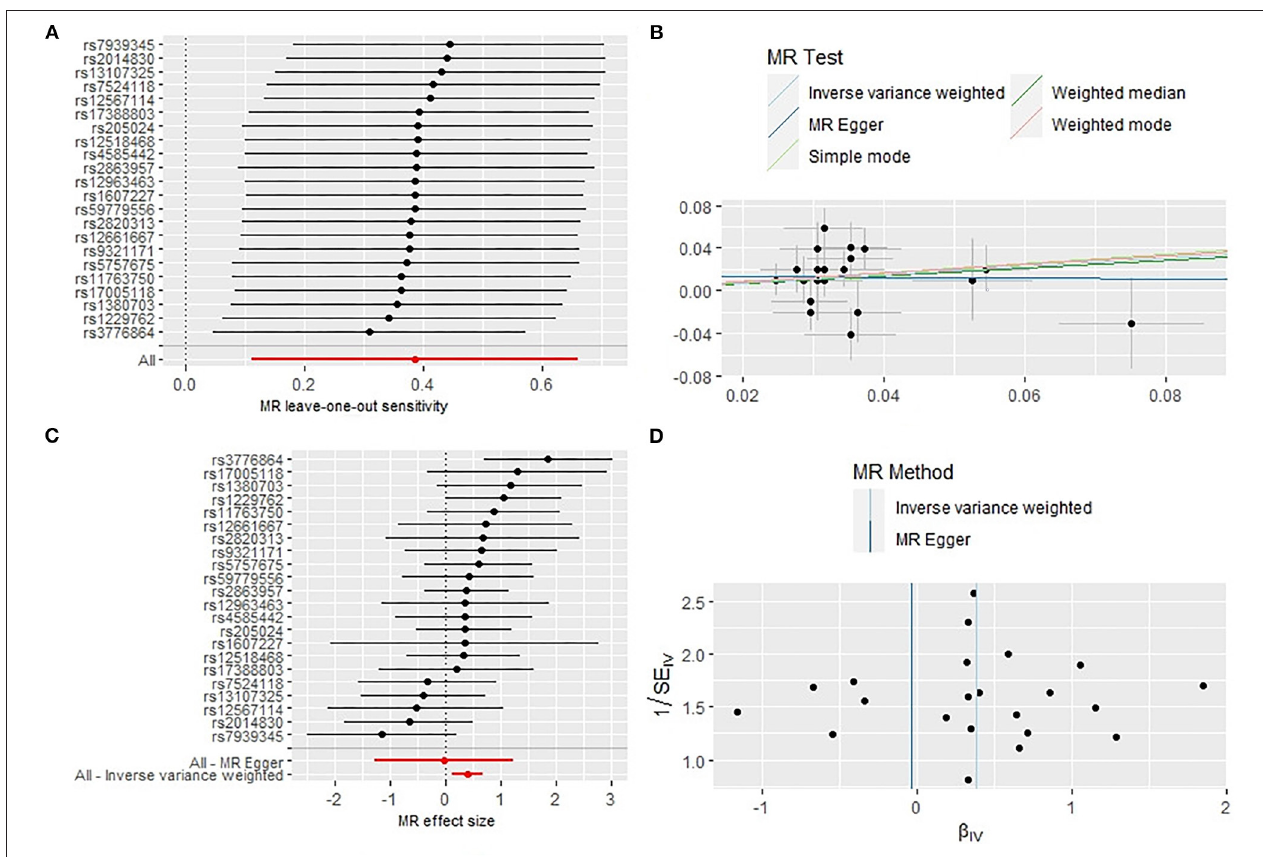
FIGURE 1 | Sensitivity analysis (A) , scatter plot (B) , forest plot (C) , and funnel plot (D) of the causal effect of short sleep duration on RA risk.